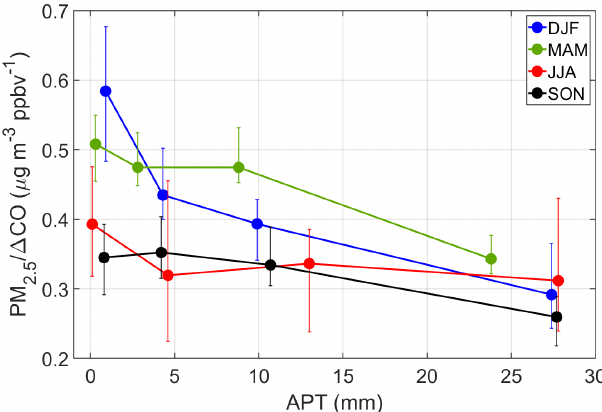
Figure 7. Seasonal sensitivity of PM 2 . 5 /(cid:49) CO to APT for Cluster 1 trajectories, divided based on four APT bins that have a similar number of data points per season. Markers denote median values, and error bars represent the 95% confidence interval for medians based on a bootstrapping method ( n = 100000). Number of points per marker: DJF = 192–194; MAM = 247–251; JJA = 107–110; SON =